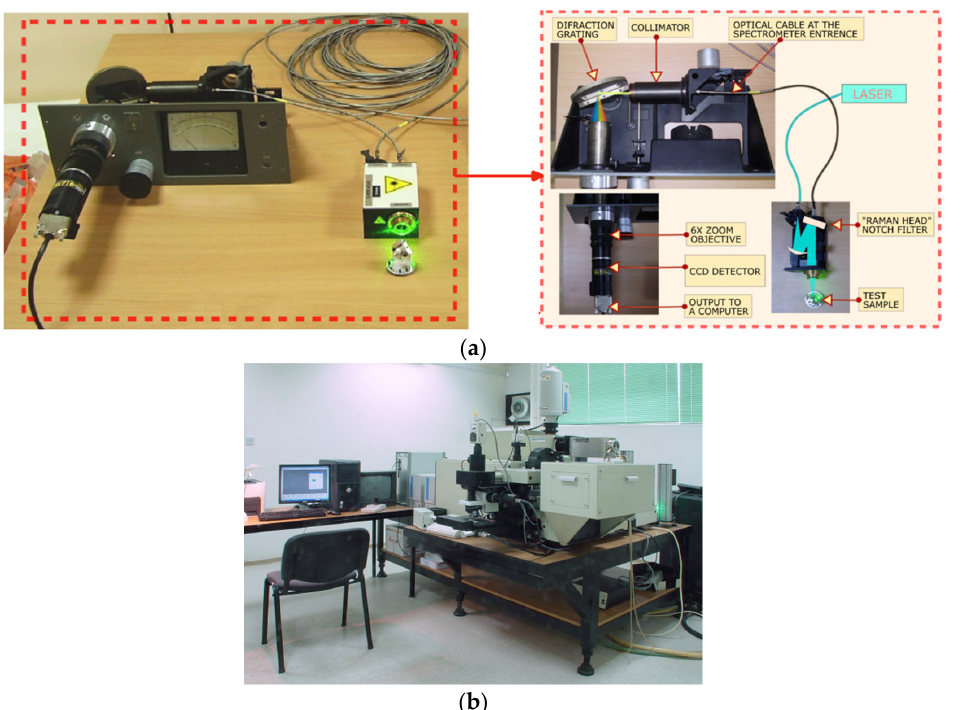
Figure 2. Assembled prototype of the proposed Raman spectrometer ( a ) and the reference Raman spectrometer JY-T64000 ( b ).